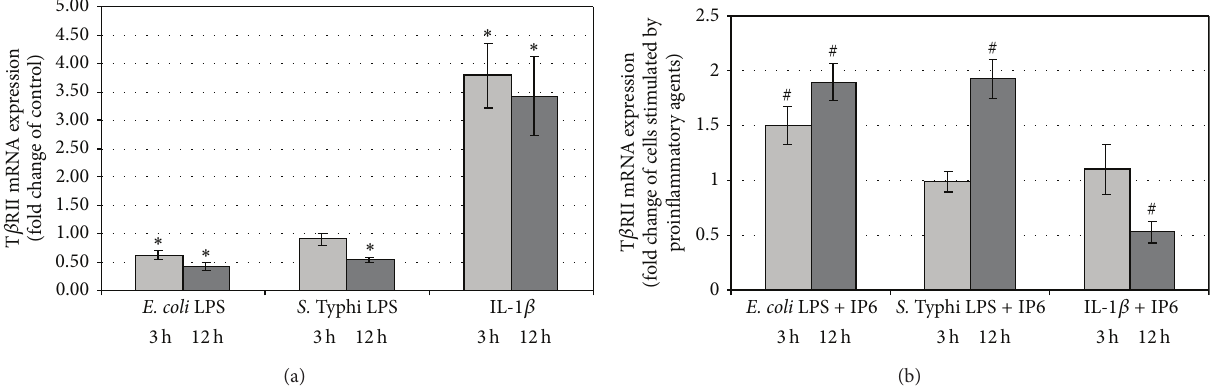
Figure 5: Expression of T 𝛽 RII gene in Caco-2 cells as determined by real-time RT-PCR. Changes in T 𝛽 RII mRNA expression in Caco-2 cells after treatment with (a) proinflammatory agents and (b) proinflammatory agents and 2.5 mM IP6 for 3h and 12h. The results are presented as mean ± SD of three separate experiments; ∗ 𝑃 < 0.05 versus control Caco-2 cells; # 𝑃 < 0.05 versus proinflammatory agents-stimulated cells.